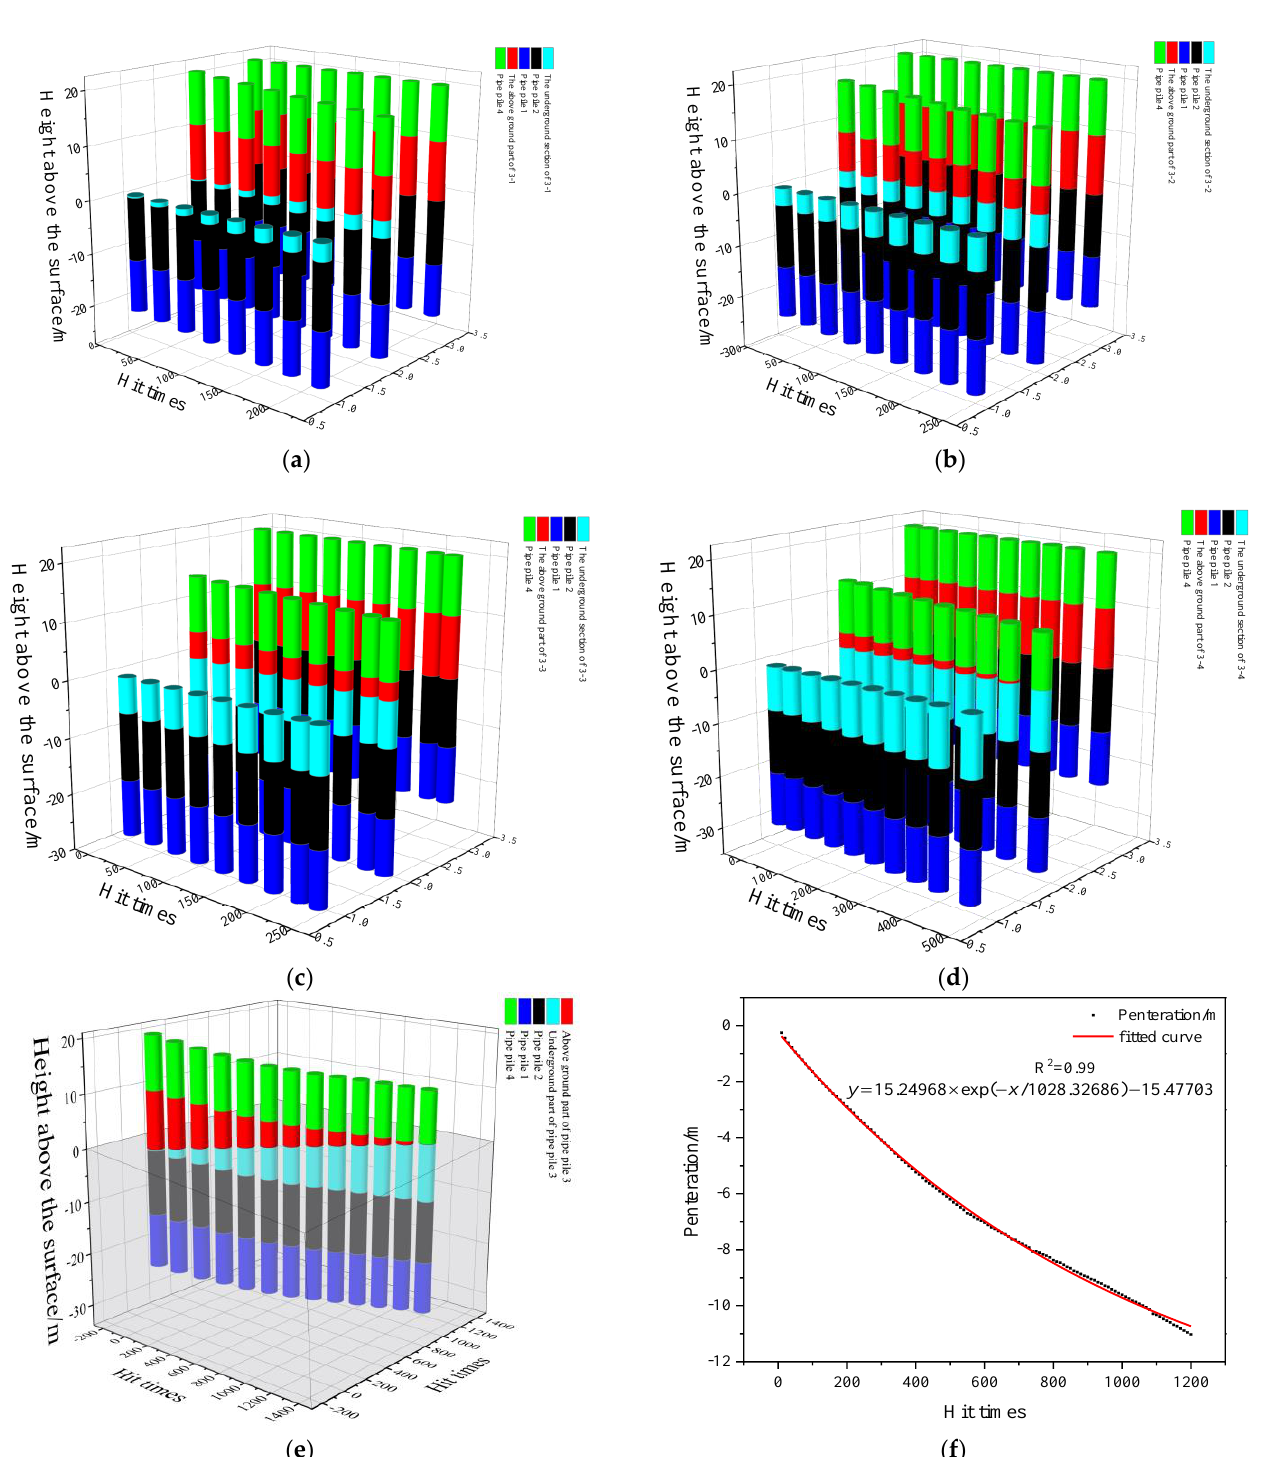
Figure 10. Schematic diagram of penetration evolution of pipe pile 3 at pile position 6, showing the ( a ) schematic diagram of pipe pile penetrated the strata in first monitoring stage, ( b ) schematic diagram of pipe pile penetrated the strata in second monitoring stage, ( c ) schematic diagram of pipe pile penetrated the strata in third monitoring stage, ( d ) schematic diagram of pipe pile penetrated the strata in fourth monitoring stage, ( e ) spatial diagram of penetration evolution law, and ( f ) fitting analysis of penetration evolution law.